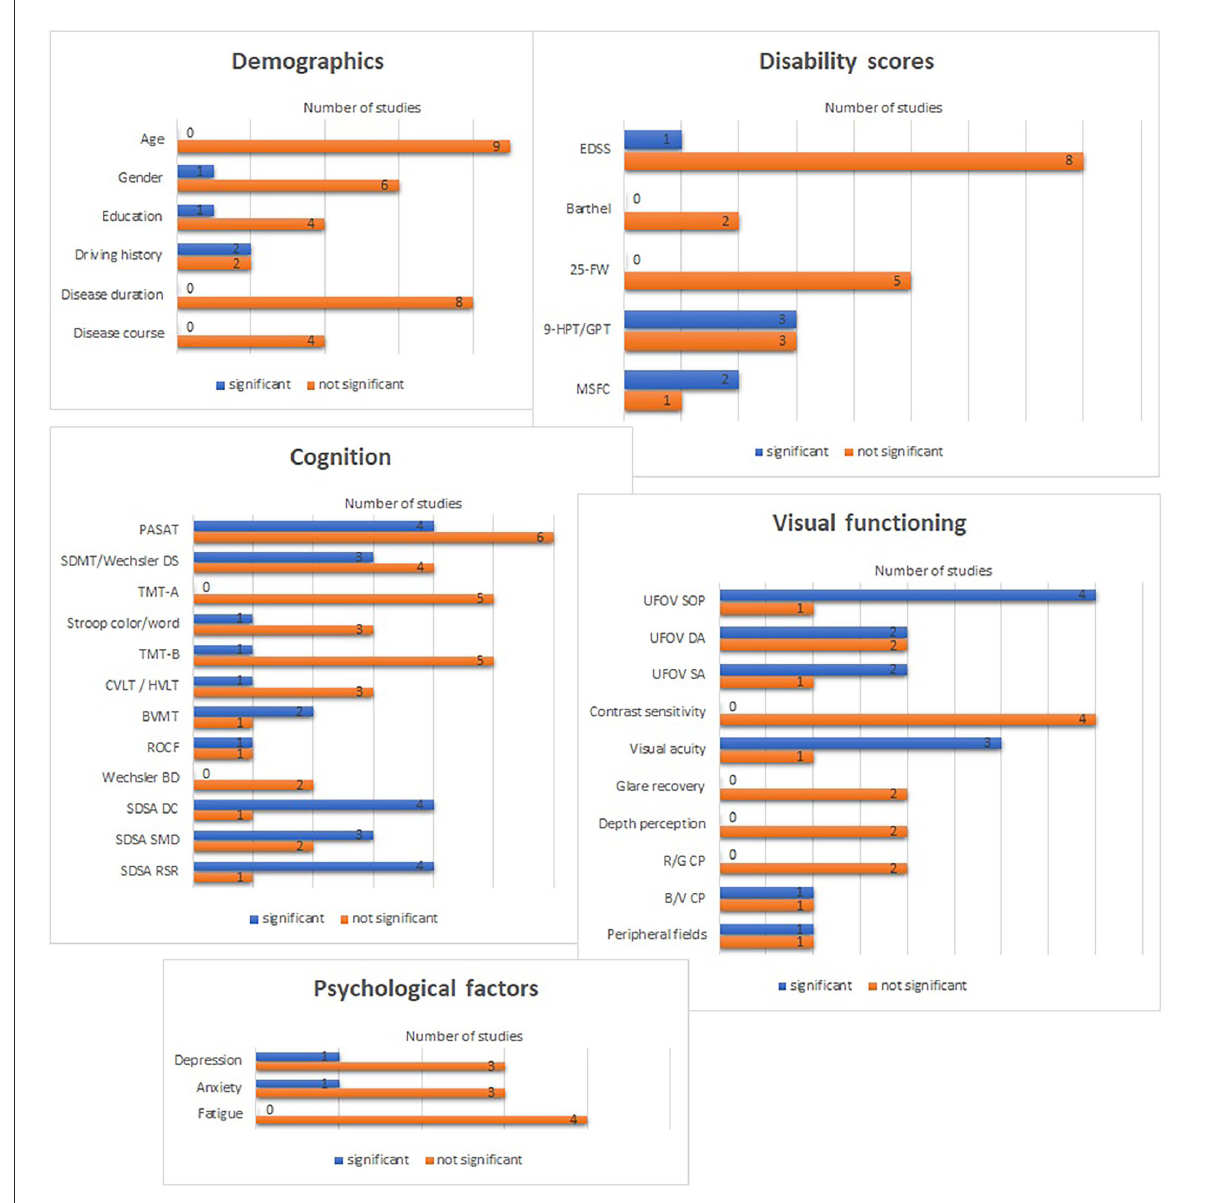
FIGURE2 Impact of disease-related abilities on driving. EDSS, Expanded disability status scale; 25-FW, 25-foot walk-test; 9-HPT, 9 Hole peg test, GPT, Grooved pegboard test; MSFC, Multiple sclerosis functional composite; PASAT, The paced auditory serial addition test; SDMT, Symbol digit modalities test; DS, Digit symbol; TMT-A, Trail making test-A; TMT-B, Trail making test-B; CVLT, California verbal learning test; HVLT, Hopkins verbal learning test; BVMT, Brief visuospatial memory test; ROCF, Rey osterreith complex figure; BD, Block design; SDSA, Stroke driver screening assessment; DC, dot cancellation; SMD, Square matrices directions; RSR, Road sign recognition; UFOV, Useful field of view; SOP, Speed of processing; DA, Divided attention; SA, Selective attention; R/G CP, Red & green color perception; B/V CP, Blue & violet color perception.